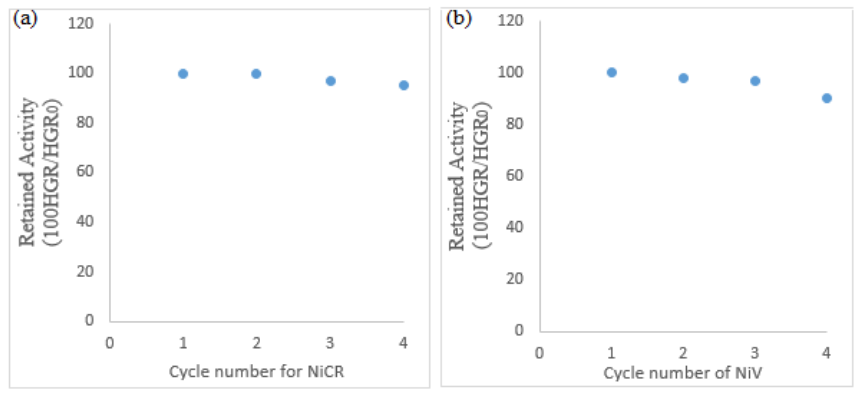
Figure 8. The reusability of thin-film catalysts for KBH 4 hydrolysis for four cycles: ( a ) NiCr catalyst reusability and ( b ) NiV catalyst reusability.